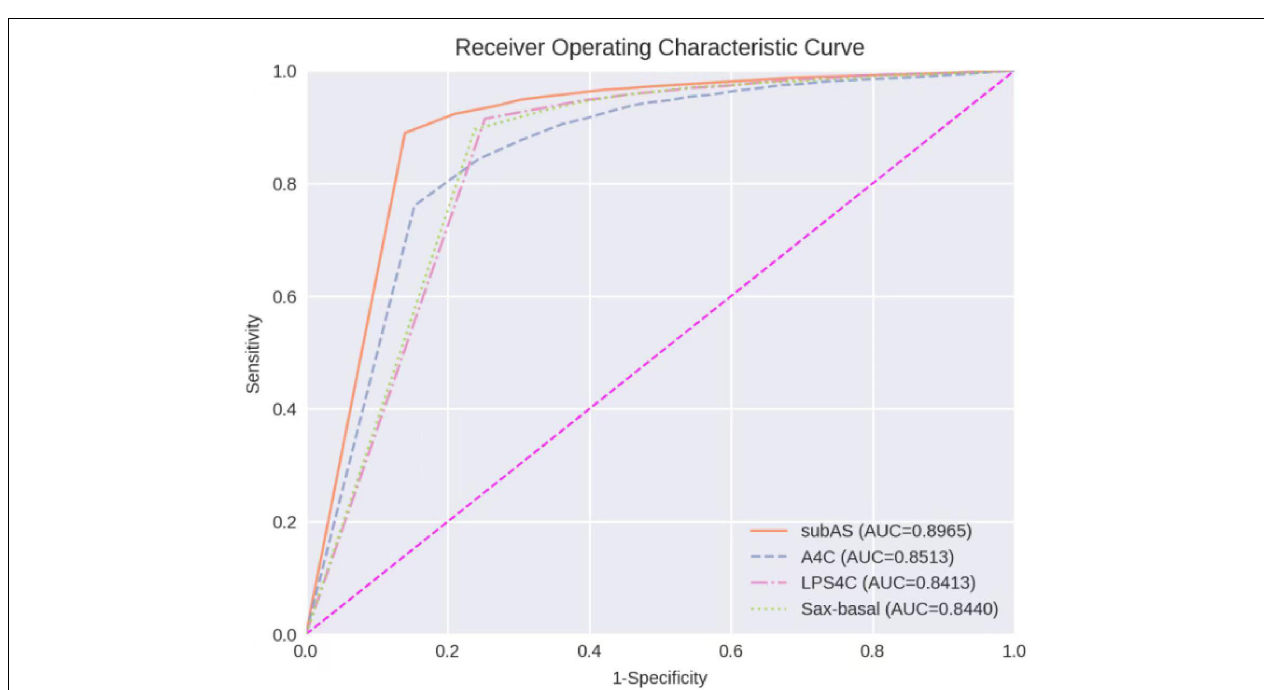
FIGURE 8 | Receiver operating characteristic curves of ASD detection on four target echocardiographic